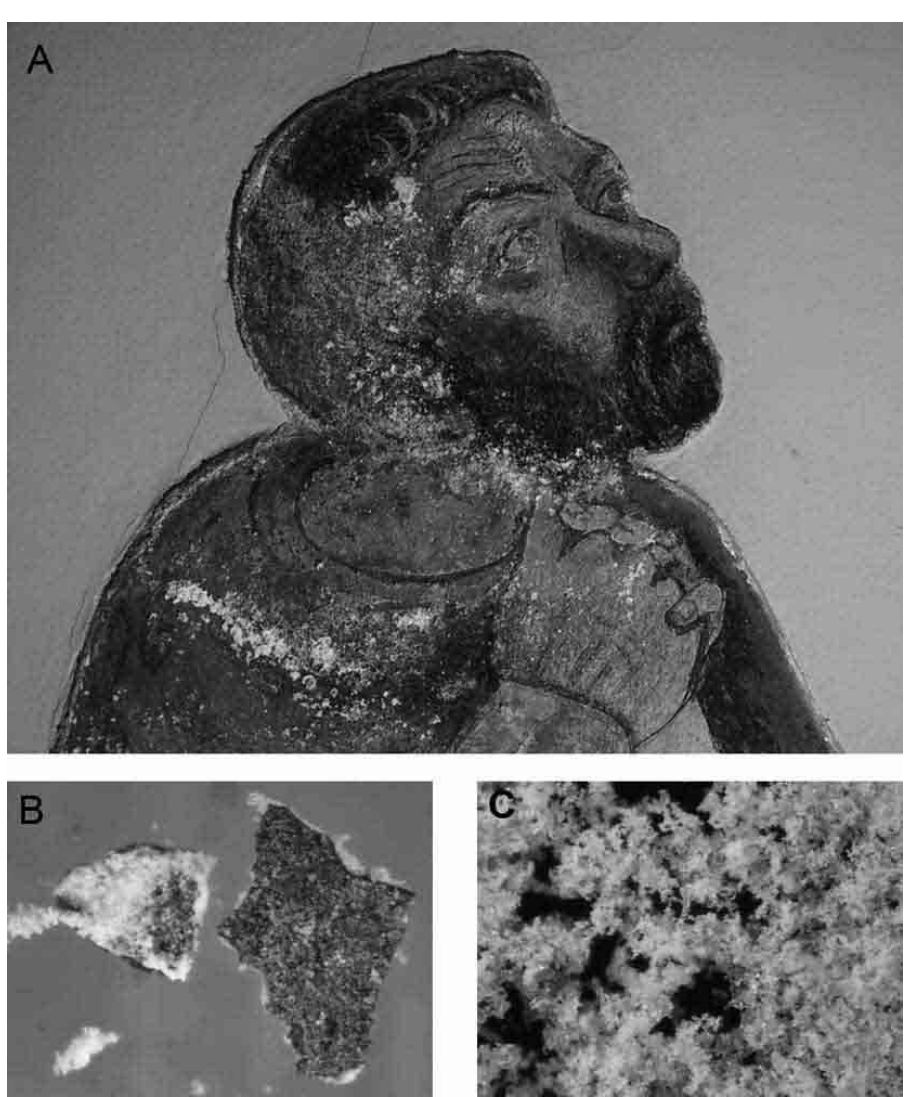
Fig. 4 – Detail of the fresco Supper at Emmaus with efflorescence features (A). Fragment of pictorial layer with subefflorescence (B), photo width = 3 mm. Soluble salts seen under the stereomicroscope (C), photo width = 3